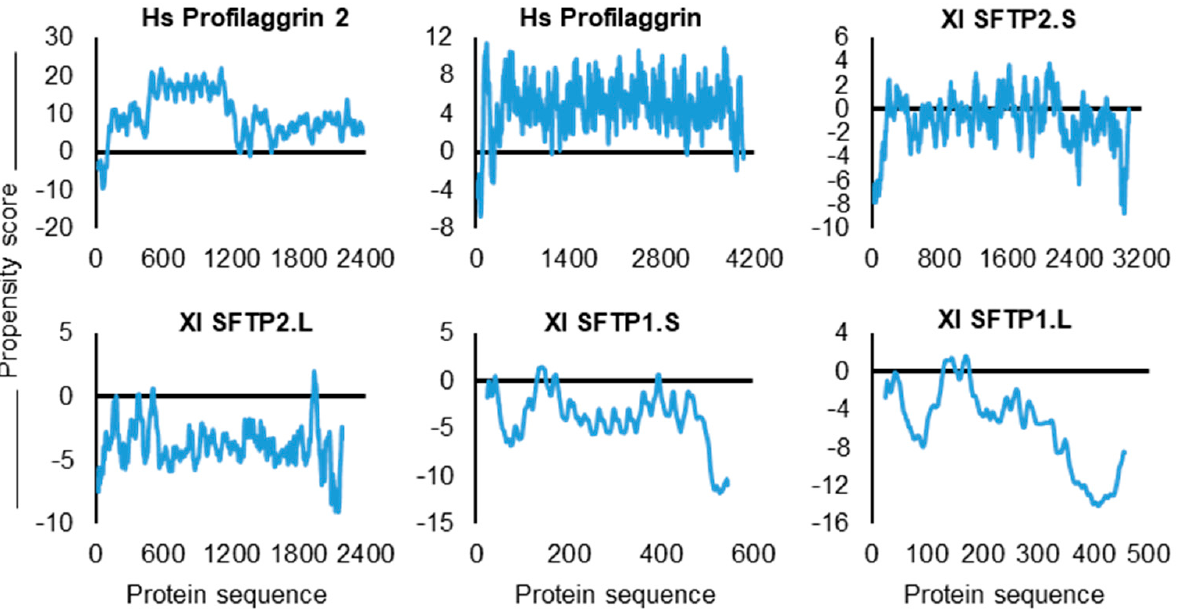
Figure 7. catGRANULE assessment of two human SFTPs, profilaggrin and profilaggrin 2, and four frog SFTPs. Graphs are ordered for the six proteins in decreasing overall propensity score as calculated within the algorithm and reported in Table 3. The plotted profile per protein amino acid residue does not provide predicted values for the first and last 25 amino acids of submitted sequences due to the sliding window size in algorithm calculations. Note scaling differences on the y-axis for propensity scores as well as the relative position of the zero